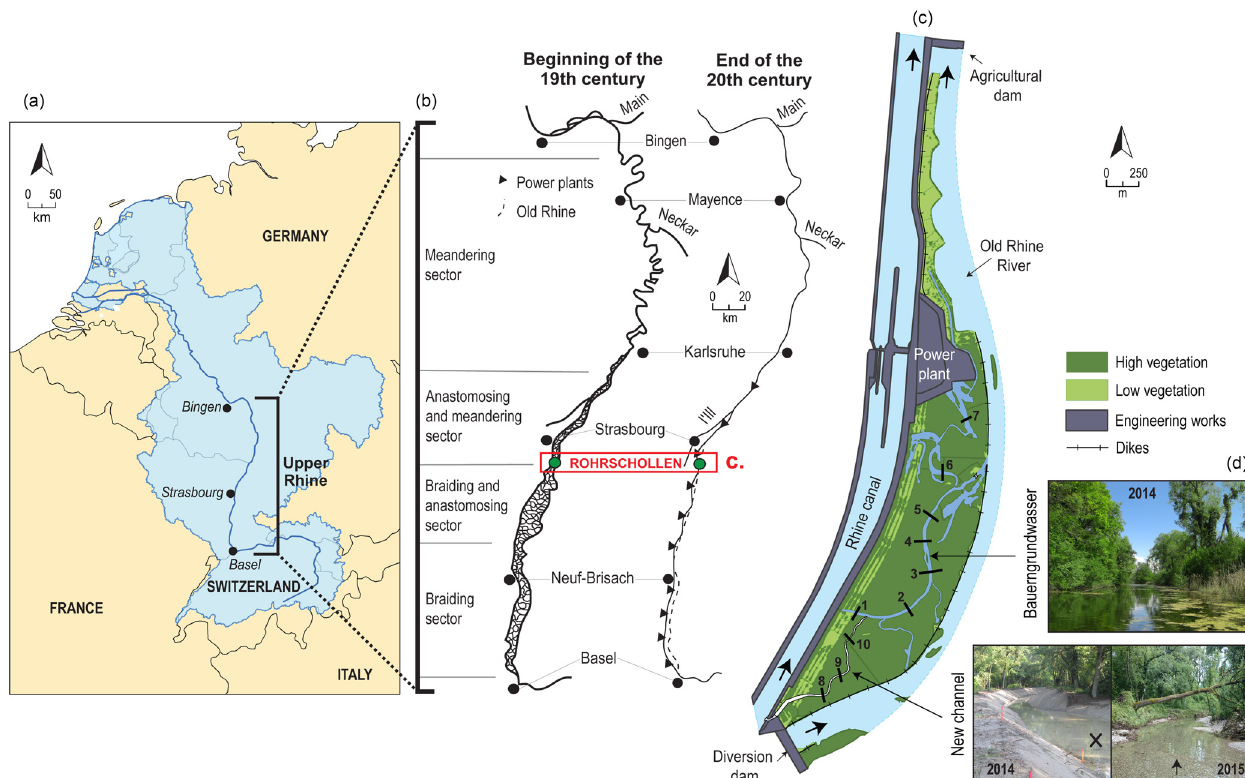
Figure 1. (a) Location of the Upper Rhine Graben, (b) channel pattern sectorization and evolution from the 18th century to present (Schmitt et al., 2009), (c) location of the study site and map of Rohrschollen Island, and (d) pictures of the Bauerngrundwasser and evolution of the new